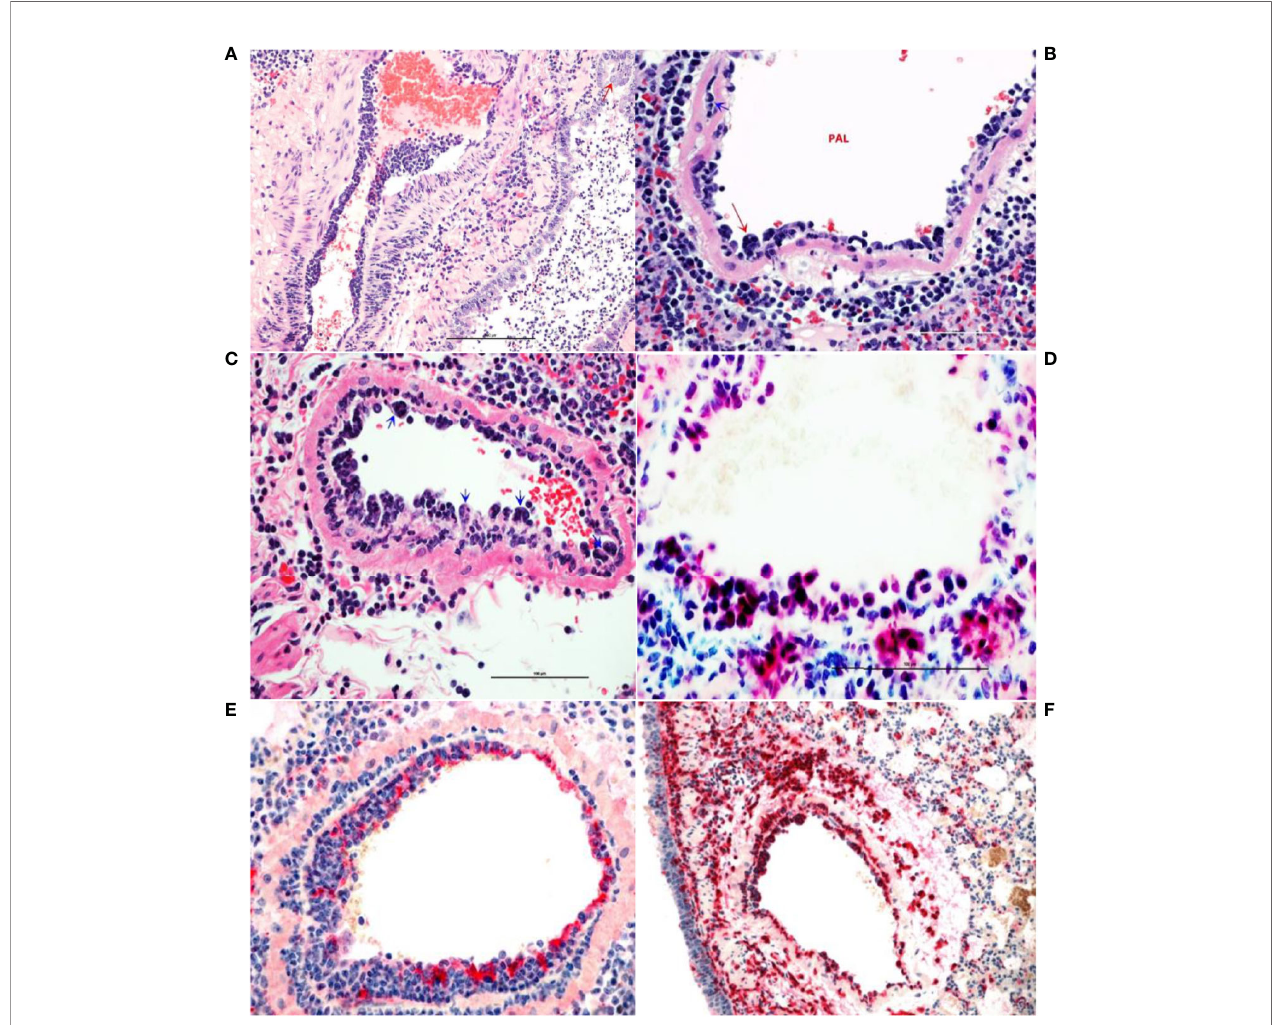
FIGURE 4 | Monocytosis and histiocytic arteritis in SARS-CoV-2-infected and untreated hamsters. (A) Major branches of pulmonary artery contain numerous monocytes adhered to endothelial cells. (B) The luminal monocytes in pulmonary artery lumen (PAL) include multinucleate cells attached to the luminal surface of endothelium (red arrow) and the vessels is surrounded by many macrophages. (C) Close-up of pulmonary artery tunica intima showing endothelial-adherent monocytes some of which are subintimal (blue arrows) or migrating through the wall of the vessels, leukocyoclastic vasculitis. (D) Luminal monocytes and perivascular macrophages showing immunoreactivity against SARCoV-2 nucleocapsid. (E) Staining the vessels intima with endothelial marker, factor VIII show discontinuity of the tunical intima by migrating monocytes. (F) Most of the cells crowding tunica intima are showing strong immunoreactivity for the macrophage marker,